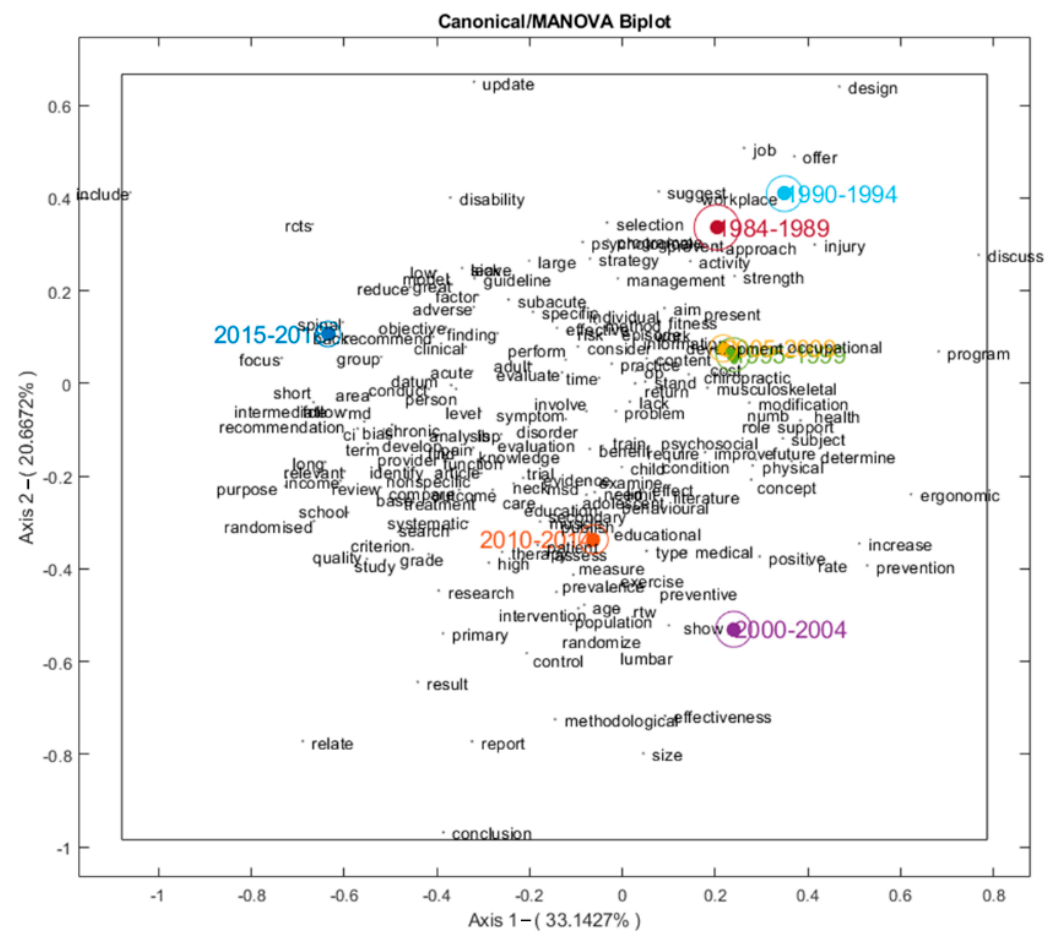
Figure 13. SRL in health sciences (low back pain prevention) using MANOVA Biplot.